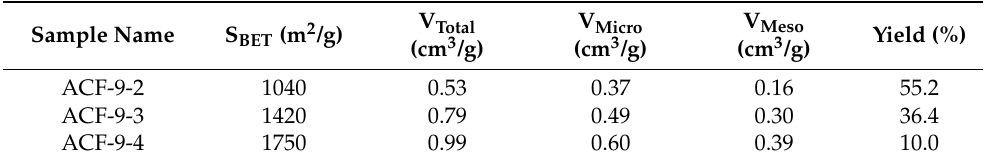
Table 4. Pore characteristics of activated carbon fibers based on LLDPE manufactured with different activation times.